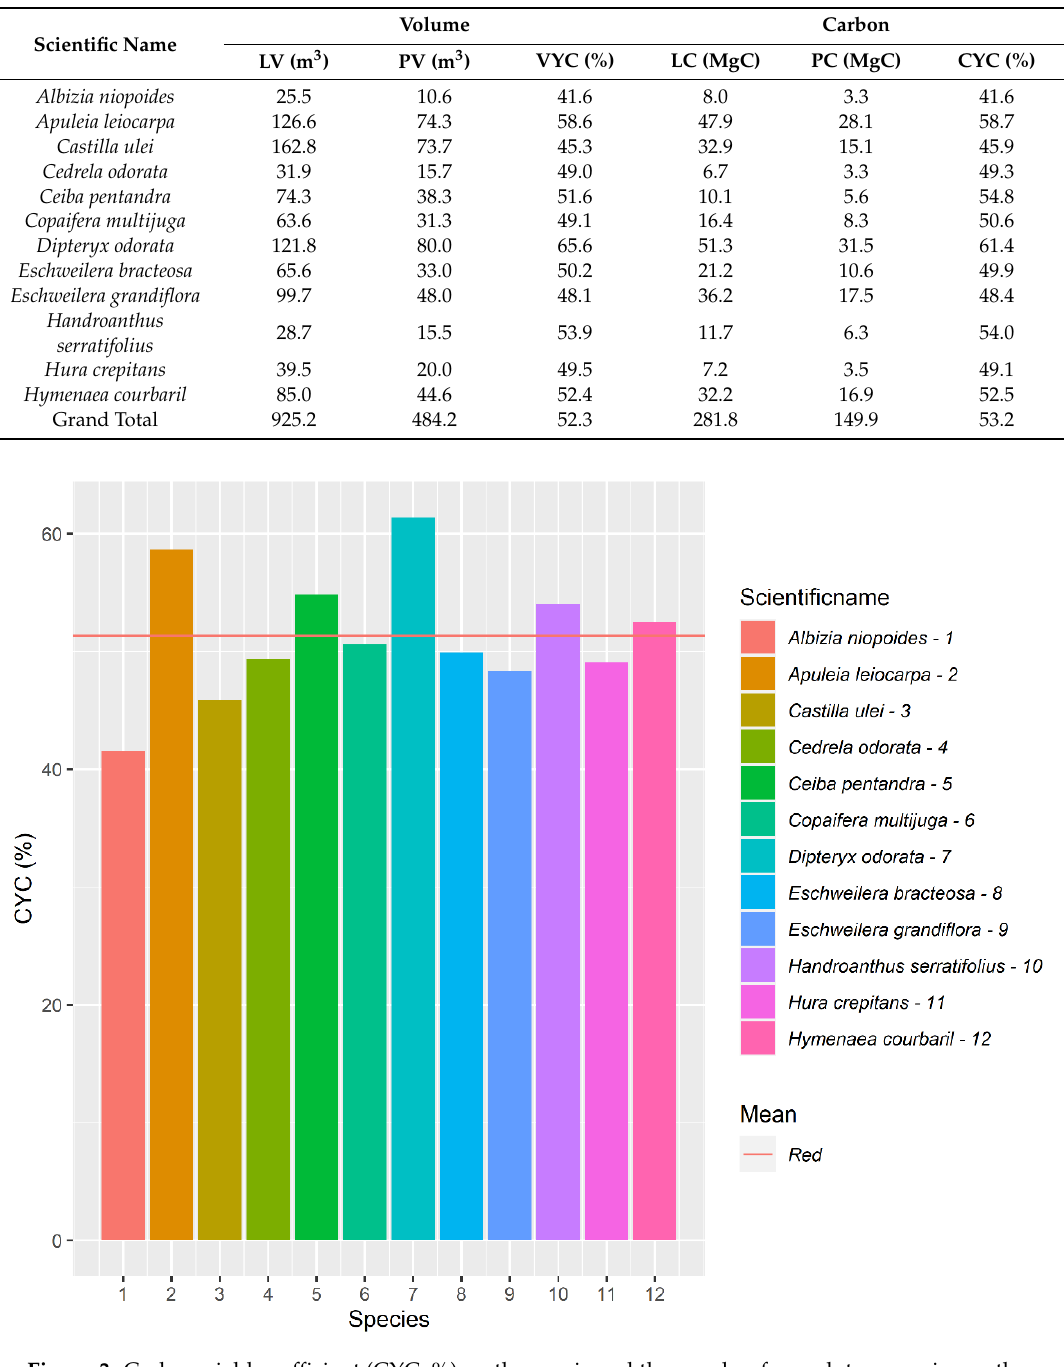
Table 3. Log volume (LV) and product volume (PV) in cubic meters (m 3 ), volumetric yield coefficient (VYC) as a percentage; log carbon (LC) and carbon stored in sawn-wood products (PC) in megagrams of carbon (MgC); and carbon yield coefficient (CYC) as a percentage for 12 species in a 1252.8-ha area harvested in a forest-management area in the state of Acre, Brazil.